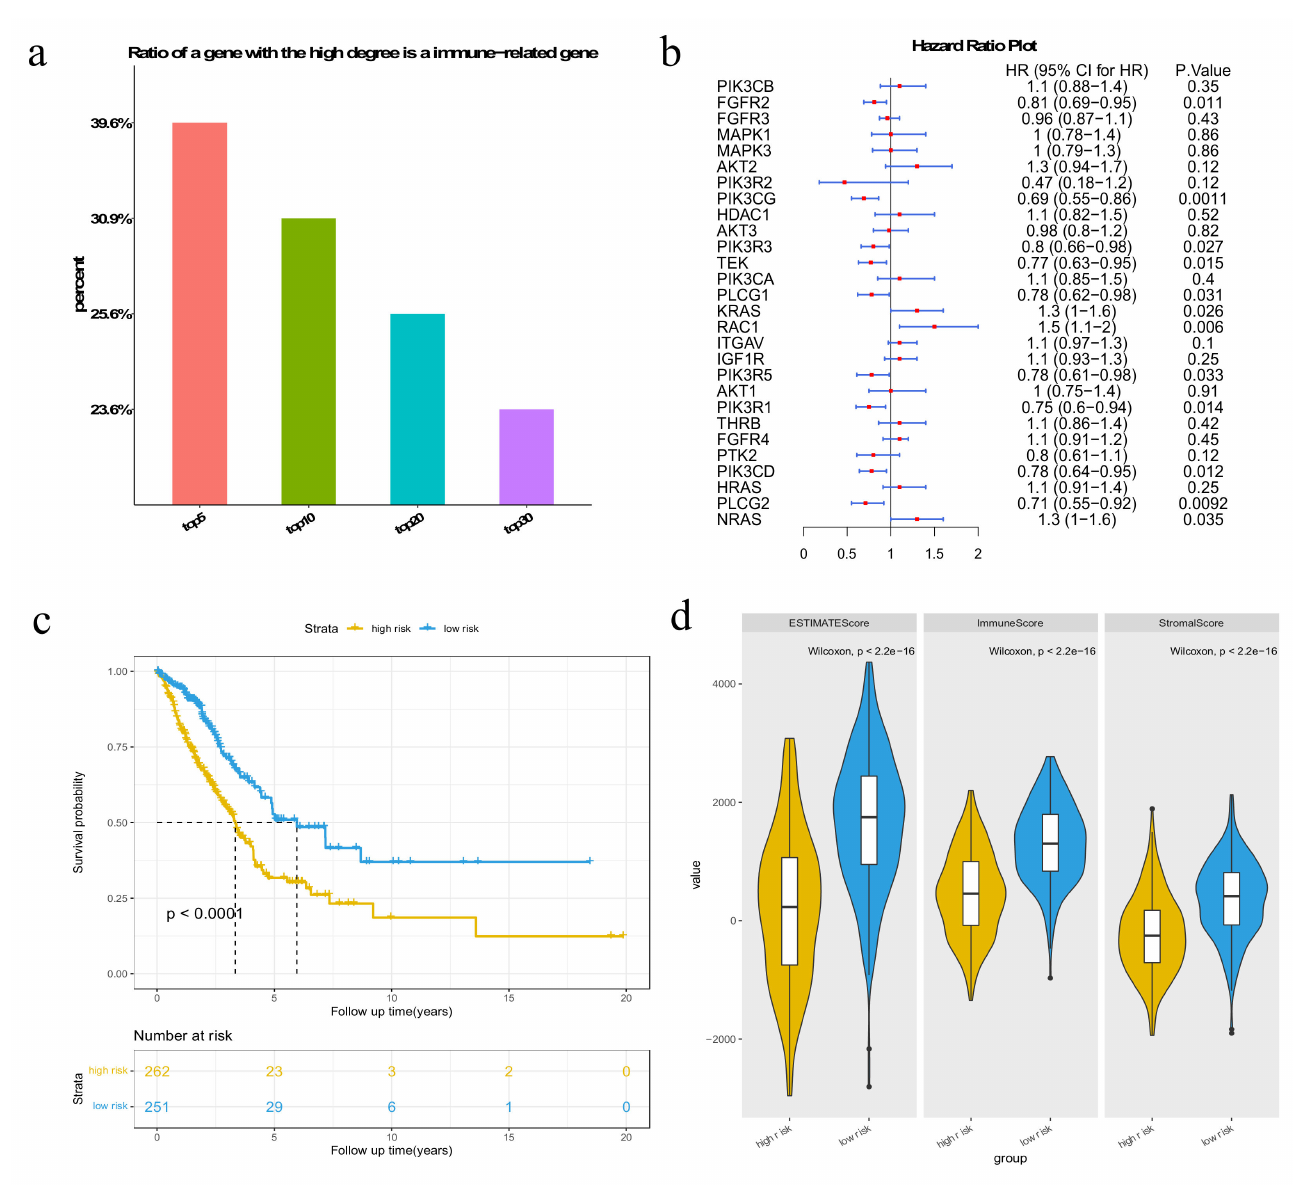
Figure 5. Results of survival analysis of both the top 5 highest-degree genes and immune-related genes. ( a ) The proportion of genes that are immune-related genes in the top 5, 10, 20 and 30 highest- degree genes in subpathways. ( b ) Forest plot of 28 genes selected by the univariate Cox proportional hazards regression model; ( c ) Kaplan–Meier survival curves of patients classified into high-risk and low-risk groups using 28 genes that belong to both the top 5 high-degree and immune-related genes in the subpathway; ( d ) box plot to show the estimate scores, immune scores and stromal scores for the patients in the above two